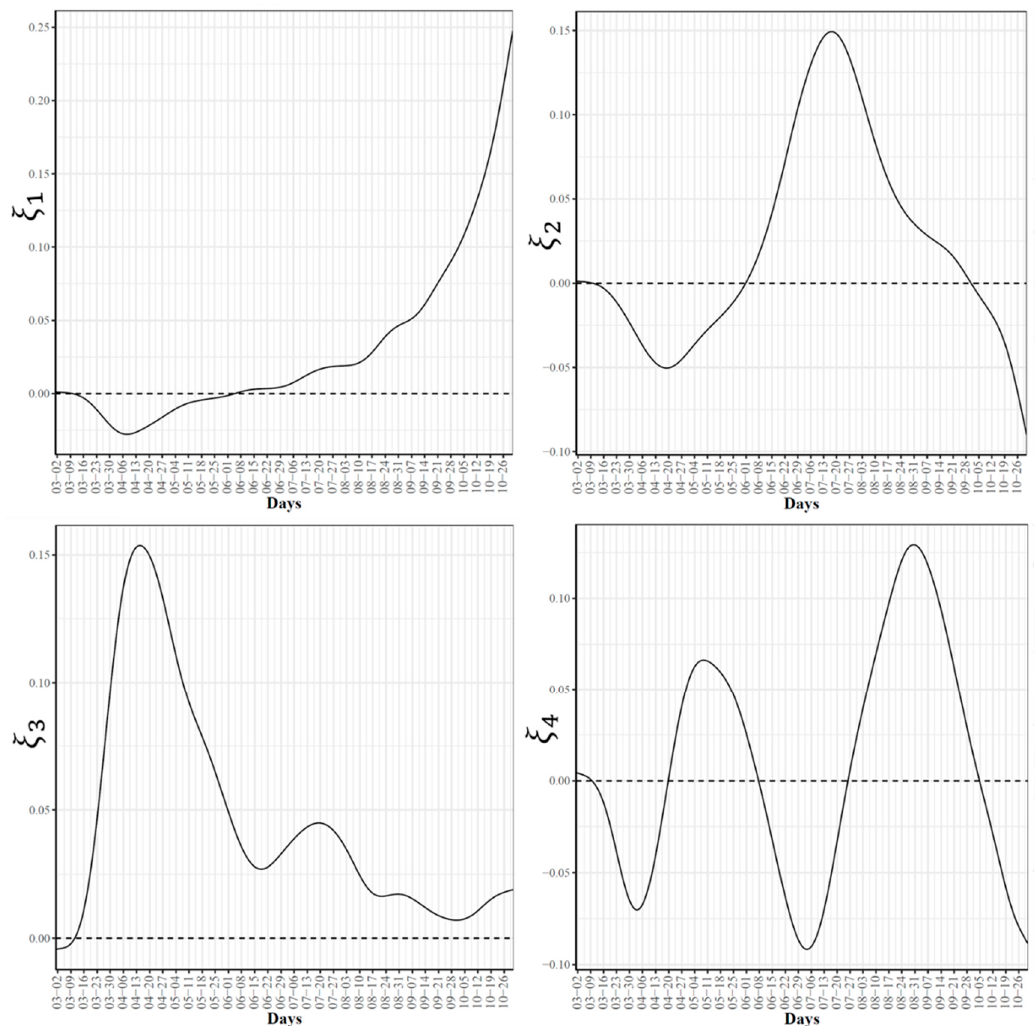
Figure 6. First four eigenfunctions of COVID-19 death trajectories.